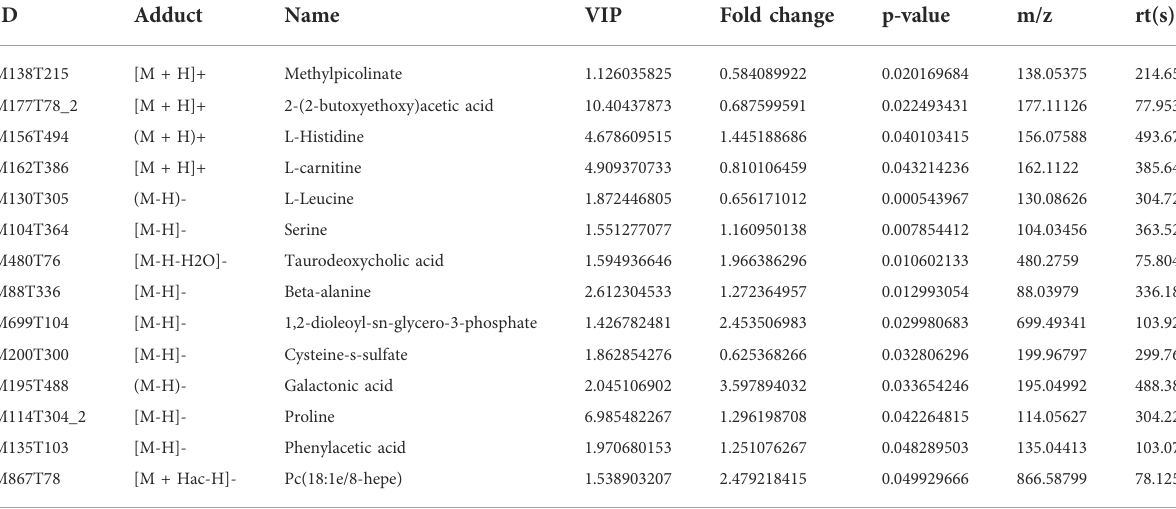
TABLE 1 Differential metabolites in positive and negative ion patterns between the Model group and the Sham group.